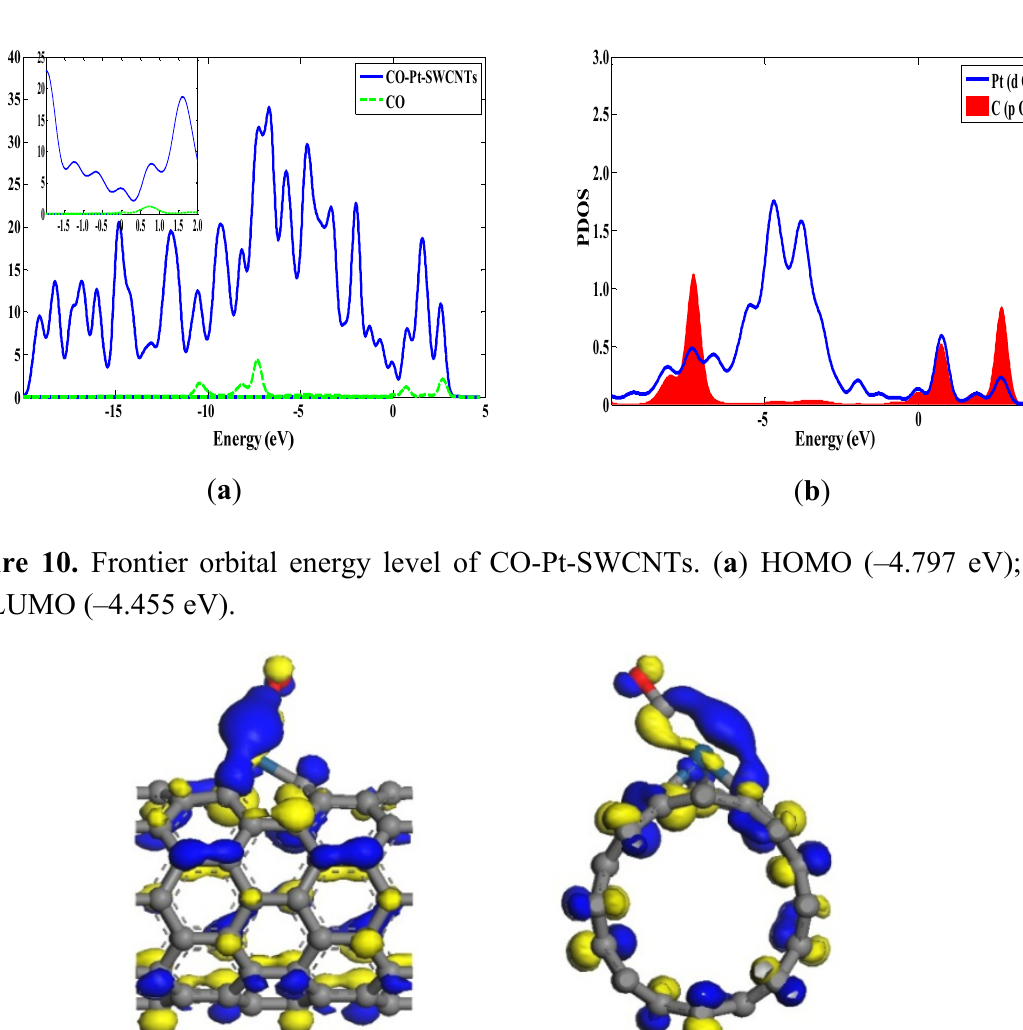
Figure 9. The density of states of CO-Pt-SWCNTs. (a) The DOS of CO-Pt-SWCNTs and the LDOS of CO in CO-Pt-SWCNTs. (b) The PDOS of Pt and C in CO-Pt-SWCNTs.